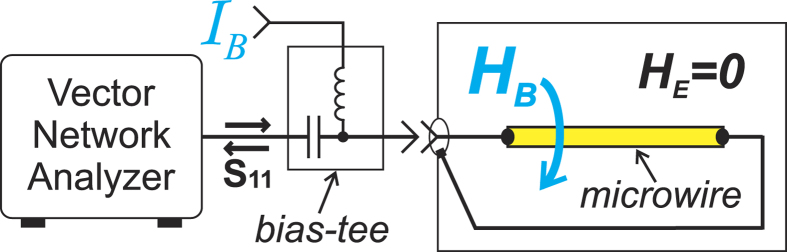
Experimental setup.